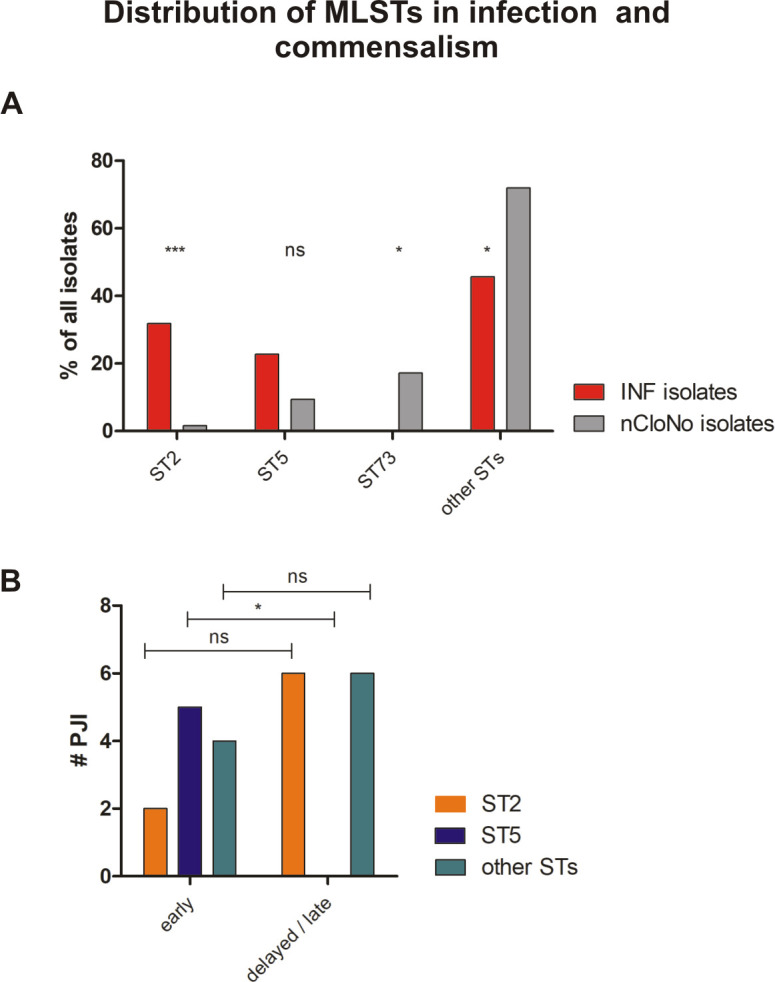
(A) Distribution of Multilocus Sequence Types (MLSTs) in INF isolates and nCloNo isolates. Red bars (INF isolates) and grey bars (nCloNo isolates) represent the proportion of indicated sequence type in invasive and commensal isolates, respectively. (B) Distribution of STs in early and delayed/late PJI. ST2 is represented by an orange, ST5 by a blue and all other STs by a green bar. Early infections: occurrence within 0–3 months after surgery, delayed/late infections: occurrence >3 months after surgery. Levels of significance indicated by *(p≤0.05), **(p≤0.01), ***(p≤0.001).